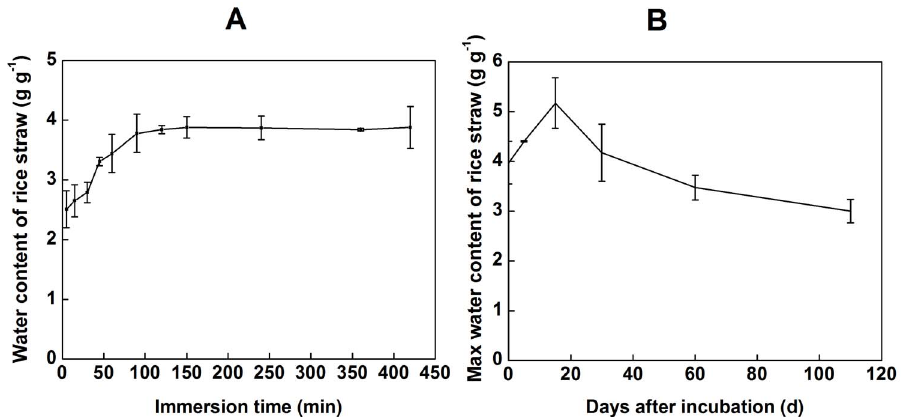
Figure 5. The kinetics of water absorption for rice straw. Panel A shows the changes of water absorption in dried rice straw. Panel B shows the changes of water absorption of straw residue for different decomposition periods. The values are the means of 3 replicates ( 6 standard deviation).